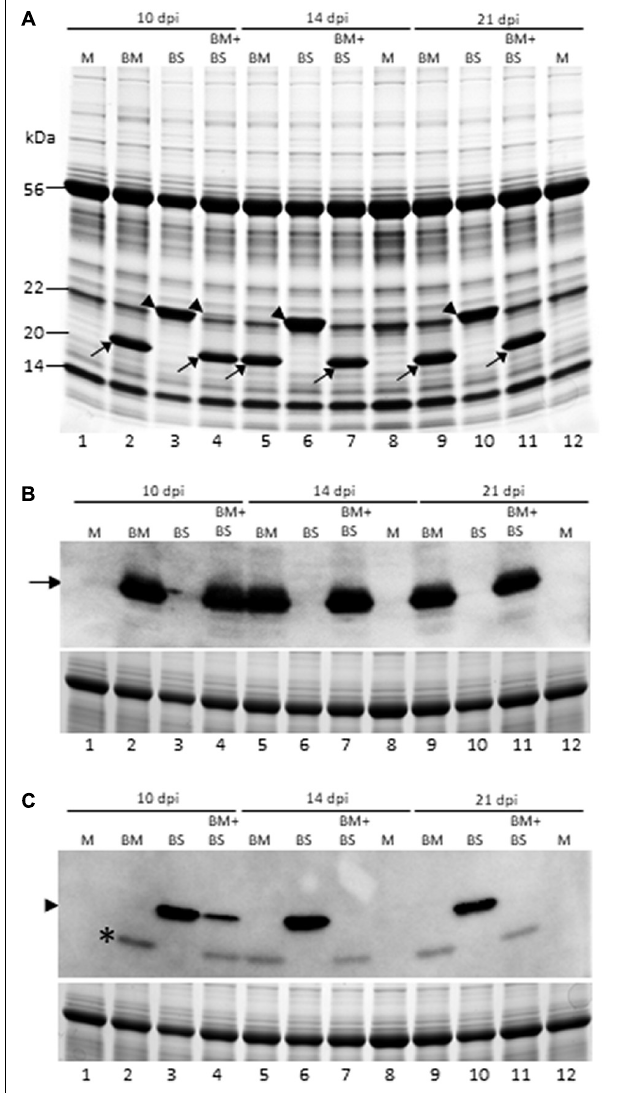
FIGURE 3 | Brome mosaic virus repressed accumulation of BSMV in co-infected wheat. (A) Coomassie brilliant blue stained SDS-PAGE gel of total proteins from singly and doubly infected wheat at 10, 14, and 21 dpi. (B,C) Western blot analysis of total proteins extracted from wheat leaves infected by BMV, BSMV, or both at 10, 14, and 21 dpi with BMV- (B) and BSMV-specific (C) polyclonal antibodies. Lower panels (B,C) are Coomassie blue-stained SDS-PAGE gels showing the large subunit of wheat RuBisCo protein as a loading control for total protein loaded per well for immunoblot assay. Lanes 1, 8, and 12: mock-inoculated wheat; lanes 2, 5, and 9: BMV-infected wheat; lanes 3, 6, and 10: BSMV-infected wheat; and lanes 4, 7, and 11: BMV + BSMV-infected wheat. Lanes 1–4: 10 dpi; lanes 5–8: 14 dpi; and lanes 9–12: 21 dpi. Location of BMV and BSMV CPs were indicated with arrows and arrowheads, respectively. *The nature of this protein in “C” with BSMV antiserum from BMV-infected wheat is not known.